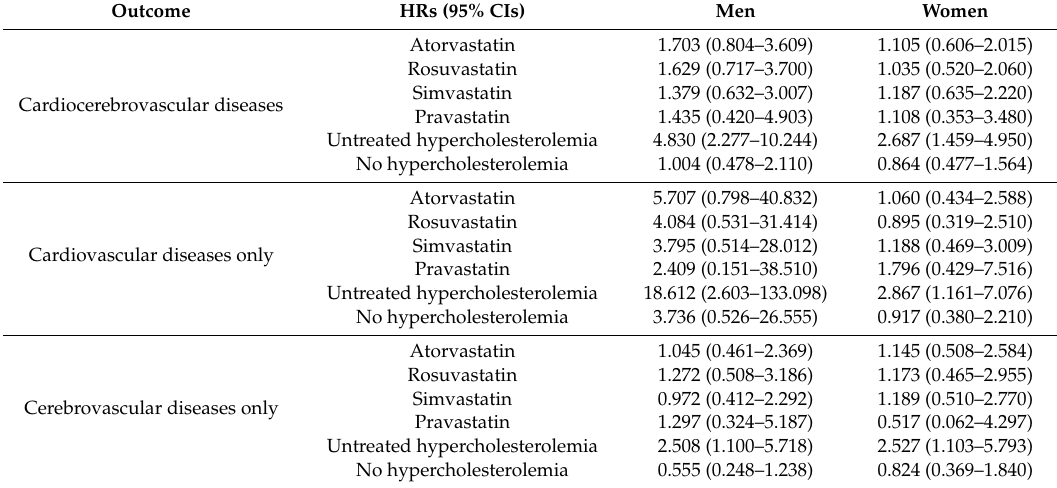
Table 3. Cox-proportional hazard regression model for other outcomes (cardiocerebrovascular diseases, cardiovascular diseases, or cerebrovascular diseases) compared with